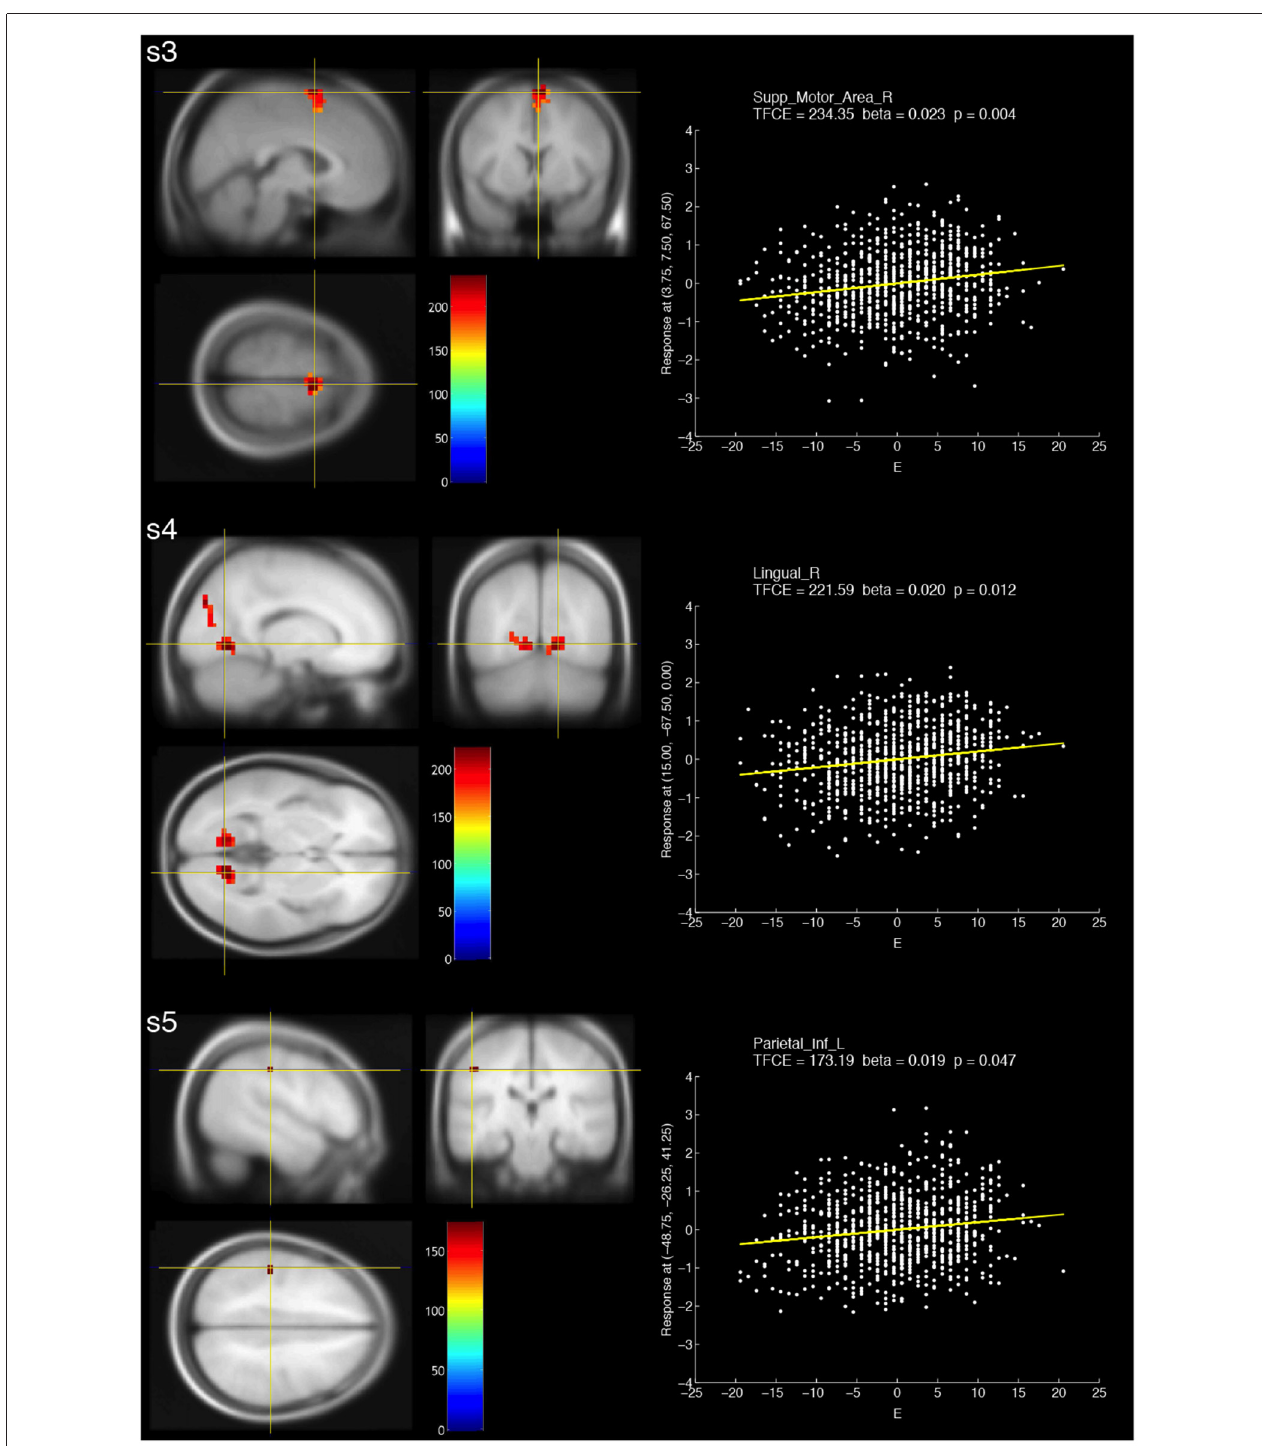
FIGURE 1 | Brain areas that showed significant positive correlations with fractional amplitude of low-frequency fluctuation (fALFF) at three different frequency bands (s3: slow-3, s4: slow-4 and s5: slow-5) and extraversion scores (E). The resulting threshold-free cluster enhancement (TFCE) maps were thresholded with a voxel-wise significance of a family-wise error (FWE)-corrected p < 0.05 and overlaid on the avg305T1 template using SPM8. The color bar indicates the TFCE magnitude. The peak voxels for the three bands are marked by the yellow cross-hairs. Each scatter plot shows the relationship between the E score (minus the mean value) and fALFF at the peak voxel. The nuisance covariates were regressed out at the peak voxel. Each yellow line within the scatter plot shows the fALFF predicted from the E score.